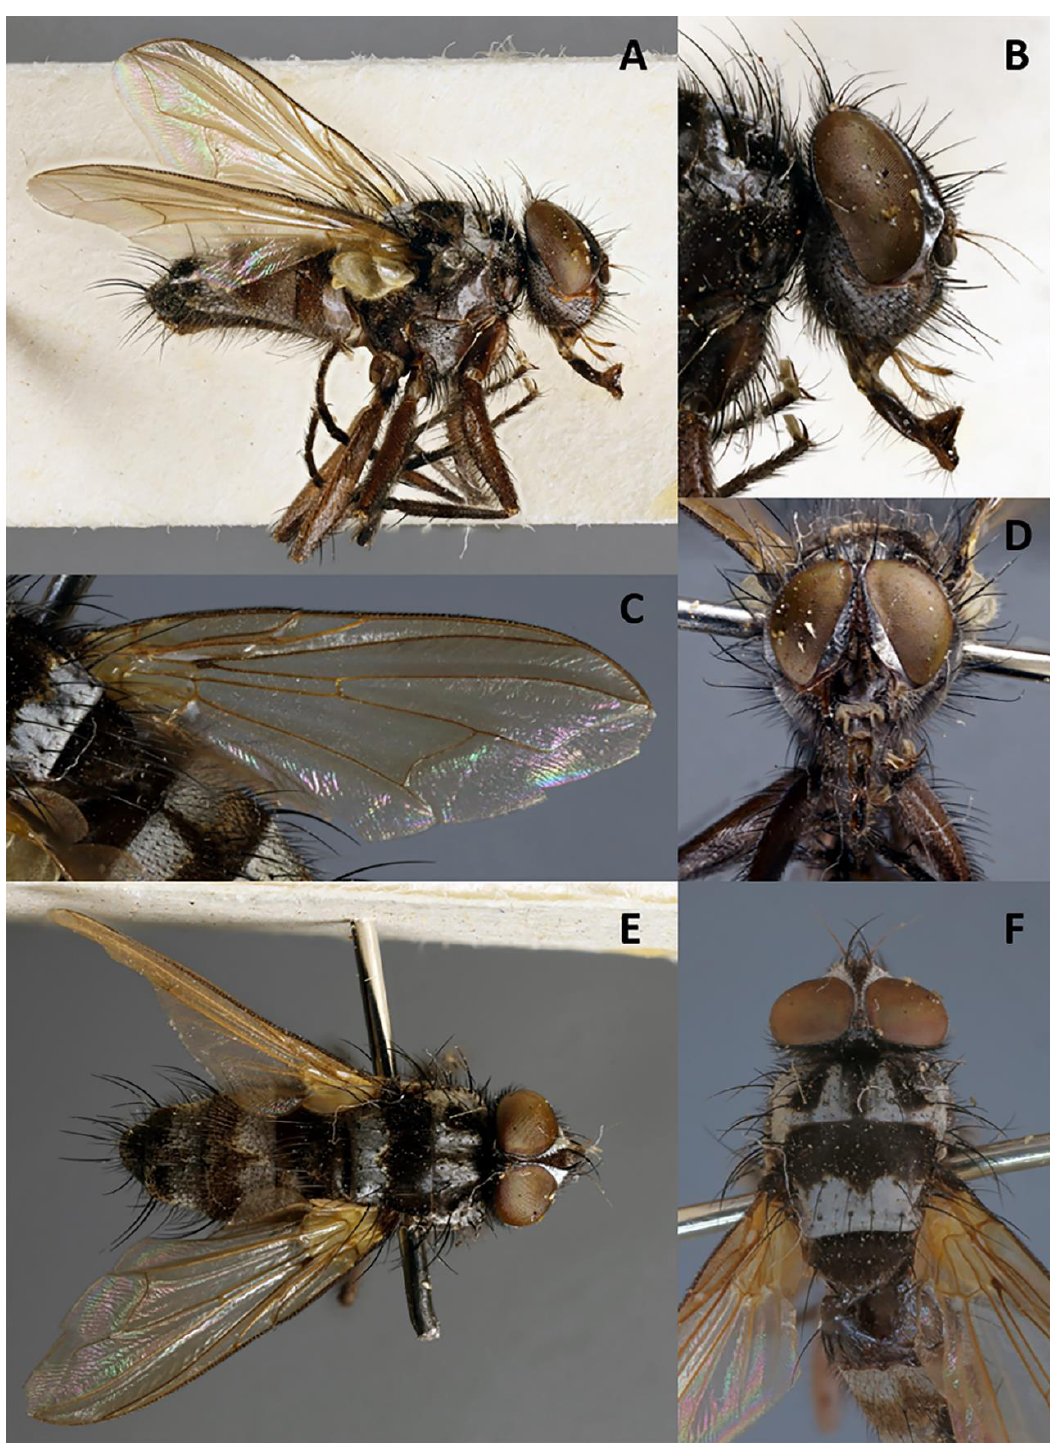
Figure 8. Phyto mambilla sp. nov. (holotype ♂ , CNC). ( A ) Habitus in lateral view; ( B ) head in lateral view; ( C ) right wing in dorsal view; ( D ) head in frontal view; ( E ) dorsal habitus; ( F ) thorax in dorsal view.